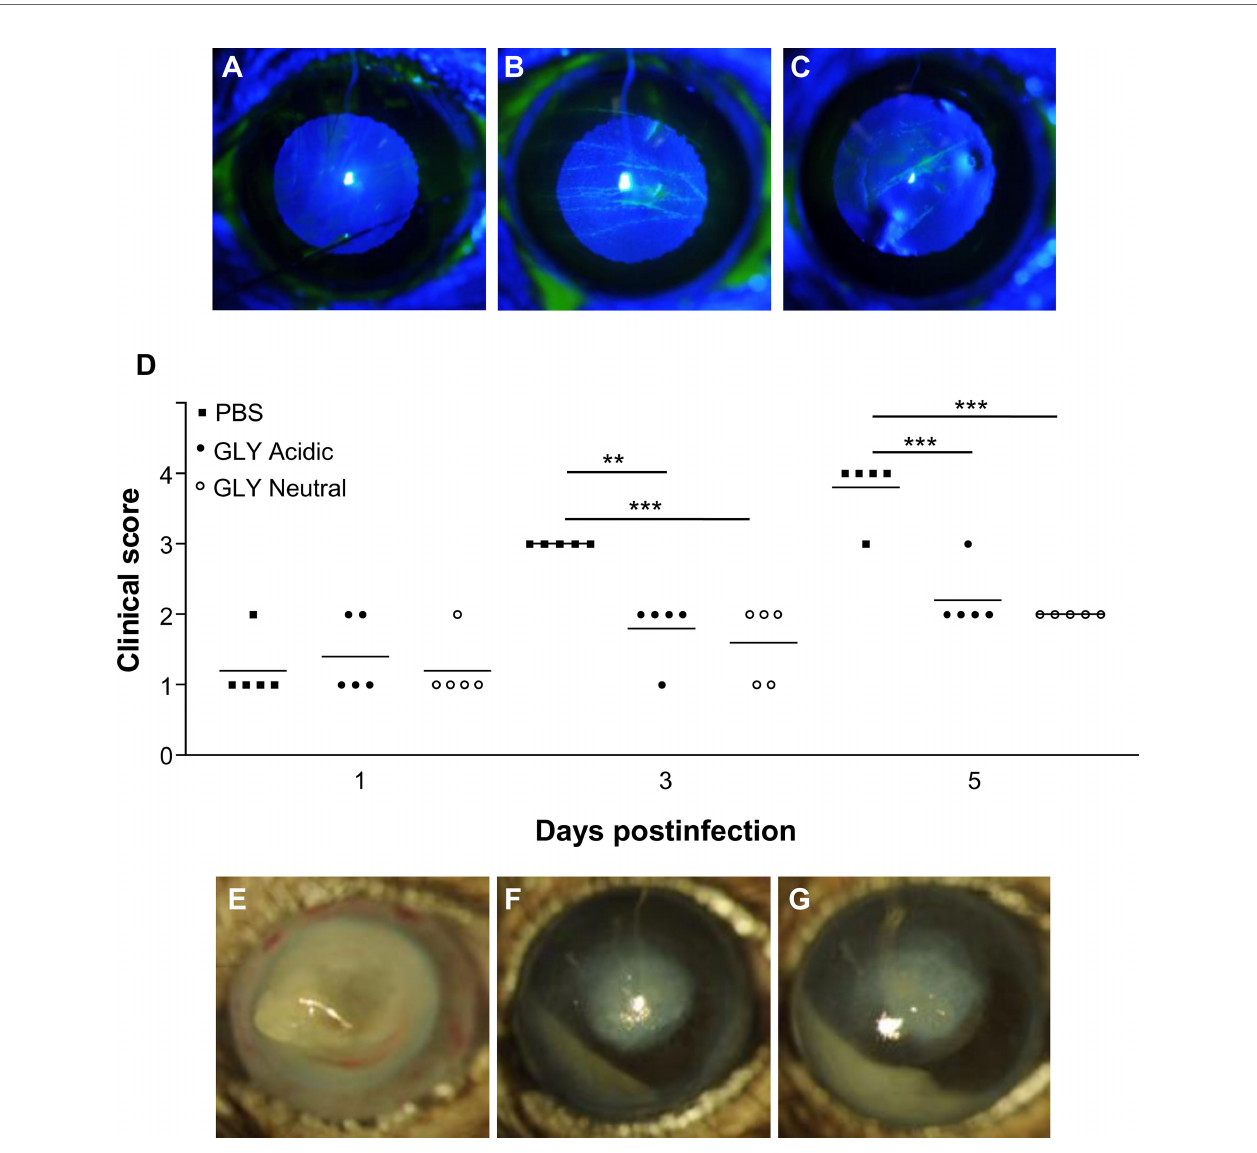
FIGURE 3 | Slit lamp photographs of fl uorescein-stained scari fi ed corneas (n = 3/group/time) that received PBS (A) , acidic (B) , or neutral (C) GLY. Wound closure was delayed at 6 h by GLY (B, C) vs . PBS (A) application where wounds were undetectable. (D – G) Effects of GLY pH on corneas infected with KEI 1025. (D) Clinical scores after treatment (beginning at 6 h p.i.) with PBS or acidic or neutral GLY at 1, 3, and 5 days p.i. Lower clinical scores were observed after treatment with acidic or neutral GLY vs . PBS at both 3 and 5 days p.i. (E – G) Slit lamp photographs from PBS (E) , or acidic (F) or neutral (G) GLY-treated corneas at 5 days p.i. show perforation only in the PBS-treated group (E) (**p < 0.01, ***p < 0.001, n =